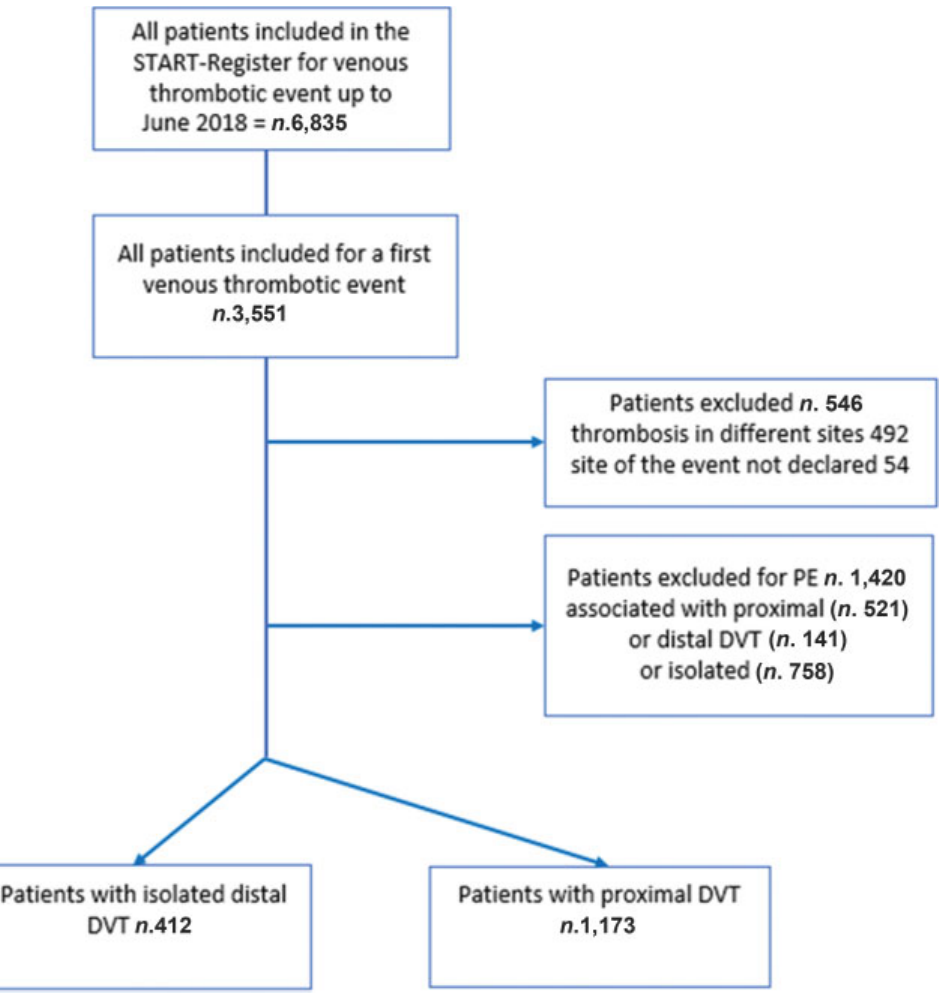
Fig. 1 Patient fl owchart. DVT, deep vein thrombosis; isolated distal DVT: thrombosis of one or more calf deep veins not involving the popliteal vein; PDVT: DVT that involves the popliteal vein and/or more proximal deep veins (with or without distal DVT); PE: pulmonary